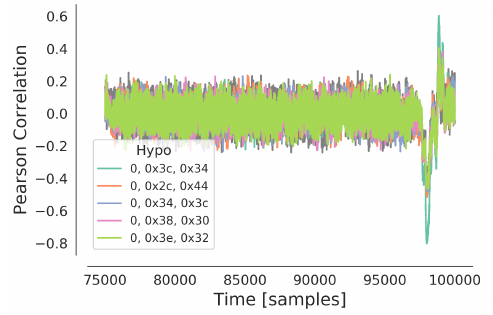
Figure 27: Pearson Correlation coefficients in Step 1 with 256 traces.